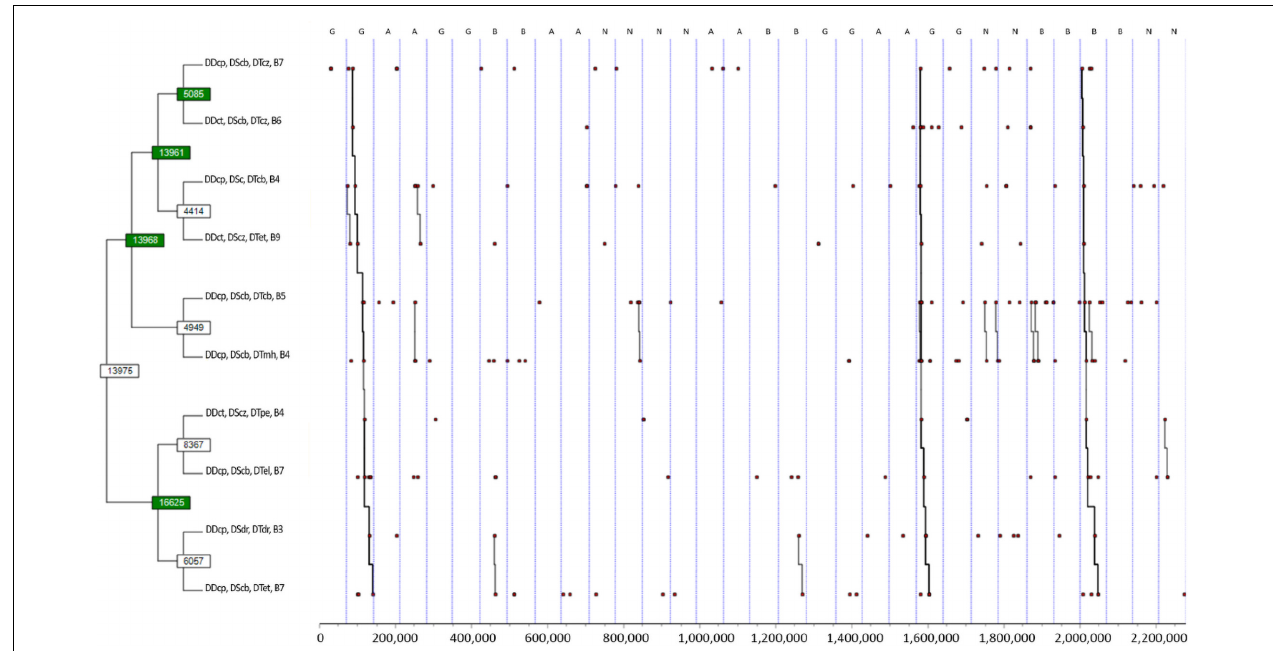
FIGURE 3 | T-pattern detection and analysis of the first, second, and third defender’s tactical–technical actions and ball field zones, using a lumping factor of 0.90 and minimum occurrence of 3. Pattern: ((((DDcp, DScb, DTcz, B7 DDct, DScb, DTcz, B6) (DDcp, DSc, DTcb, B4 DDct, DScz, DTet, B9)) (DDcp, DScb, DTcb, B5 DDcp, DScb, DTmh, B4)) ((DDct, DScz, DTpe, B4 DDcp, DScb, DTel, B7) (DDcp DSdr, DTdr, B3 DDcp DScb, DTet, B7))); A, Argentina; B, Brazil; B3, ball in right strip and ultra-defensive sector field zones; B4, ball in the left strip, defensive sector and defensive midfield field zone; B5, ball in the central strip and defensive sector field zone; B6, ball in the central strip and defensive midfield field zone; B7, ball in the right strip, defensive sector, and defensive midfield field zone; B9, ball in the central strip and offensive midfield sector field zone; DDcp, first defender pressure; DDct, first defender temporisation; DScb, second defender cover; DScz, second defender zonal cover with player marking; DSdr, second defender displacements of recovering; DTcb, third defender cover; DTcz, third defender zonal cover with player marking; DTdr, third defender displacements of recovering; DTel, third defender close longitudinal spaces; DTet, third defender close transversal spaces; DTmh, third defender player marking; DTpe, third defender control or balance positioning; G, Germany; N,